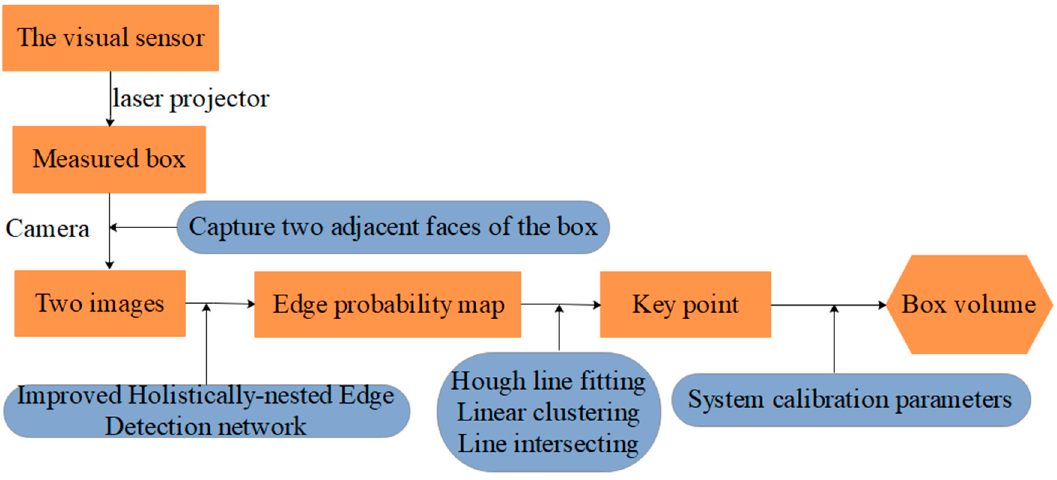
Figure 4. Workflow of the box volume measurement system.